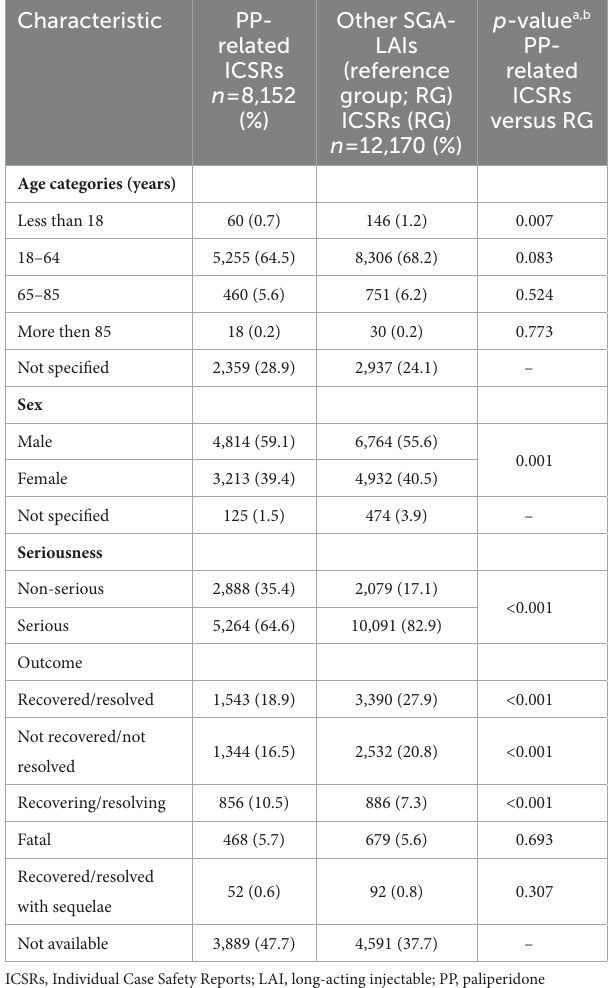
TABLE 1 Characteristics of PP-related ICSRs compared to those of other SGAs related ICSRs.